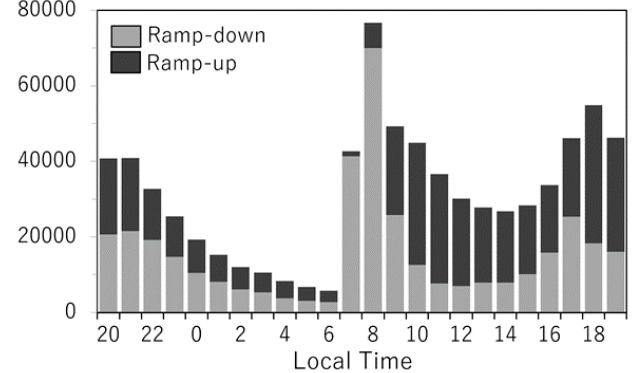
Figure 9. The annual number of occurrences of the 5% most extreme ramp-down events (grey bars) and ramp-up events (black bars) of wind speeds for each hour of a day.